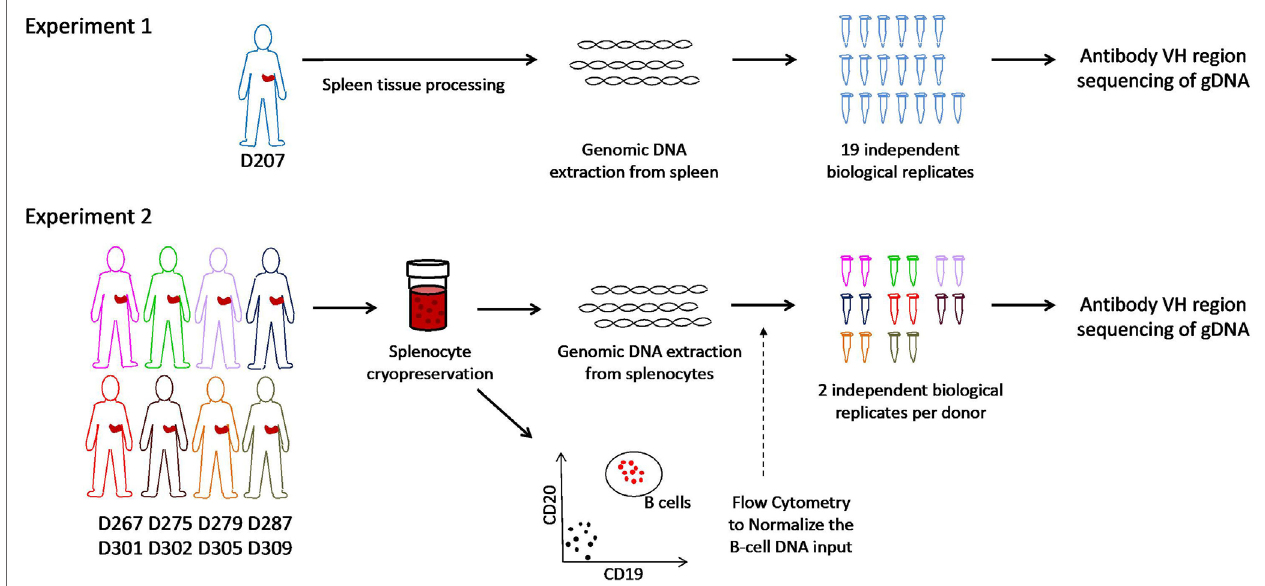
FIgUrE 1 | Schematic of experiments. In experiment 1, genomic DNA is extracted from spleen tissue of an organ donor. Immunoglobulin heavy chain gene rearrangements were amplified and sequenced from genomic DNA in 19 biological replicates. In experiment 2, splenocytes from eight different organ donors were cryopreserved at the time of organ recovery. All samples were thawed on the same day and analyzed for the B cell fraction by flow cytometry. Genomic DNA (normalized for the B cell fraction) was separately amplified and sequenced (two biological replicates per